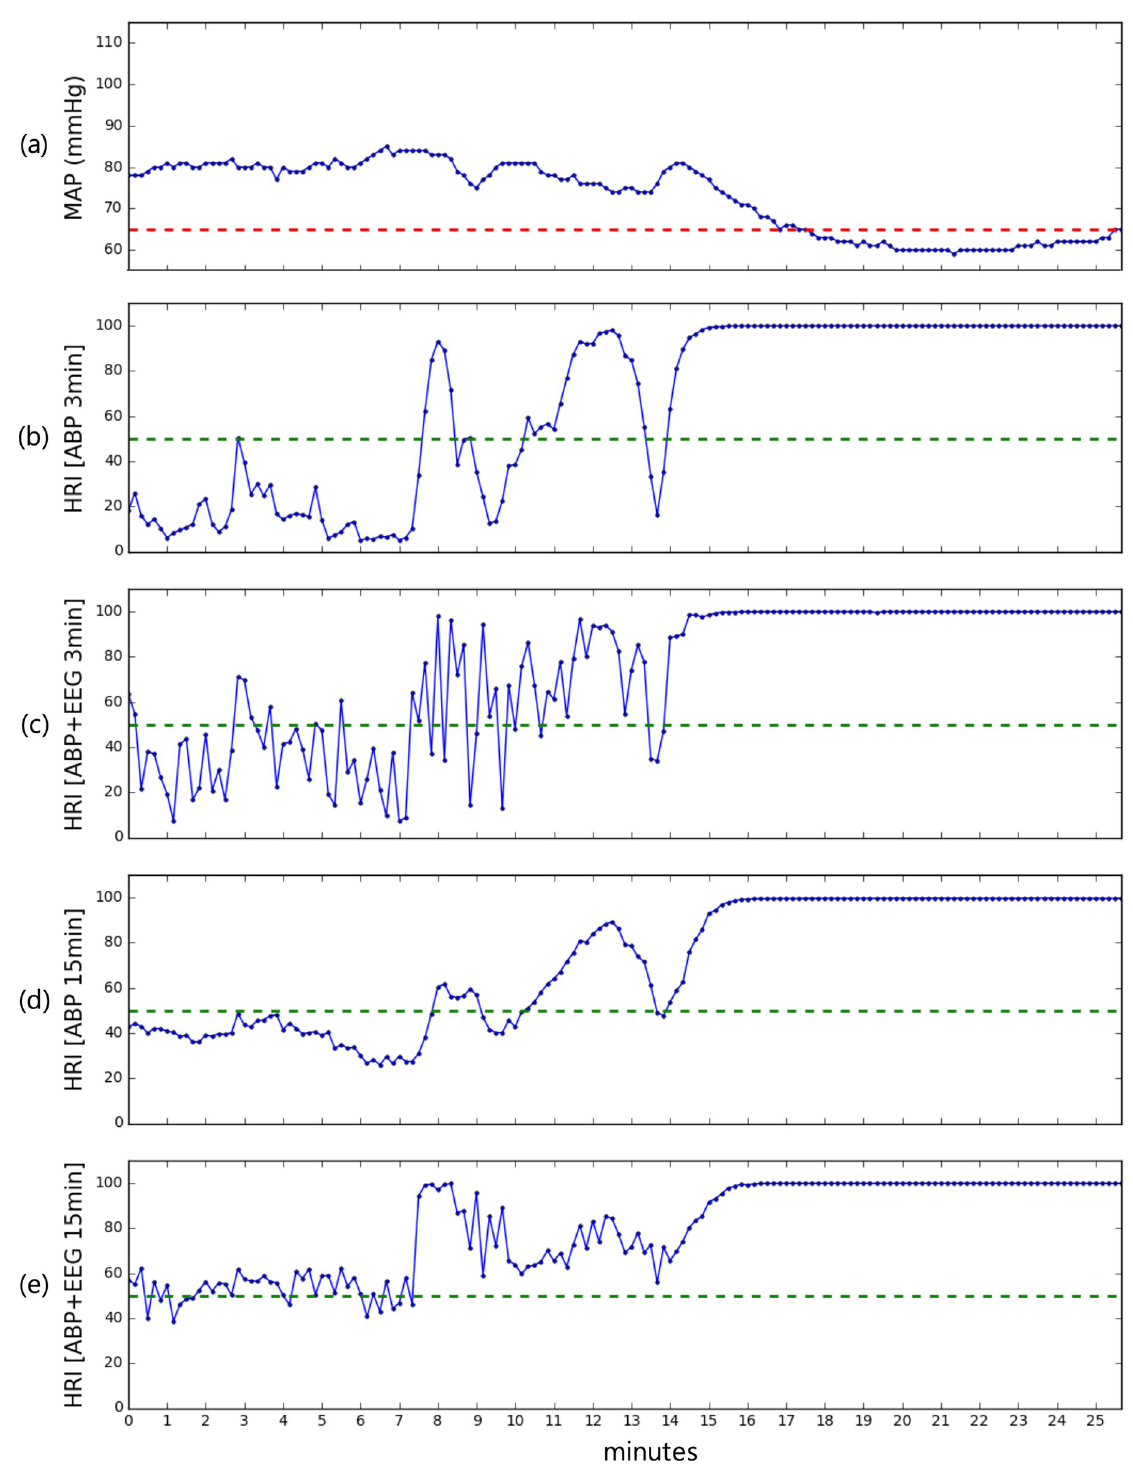
Fig 3. Illustrative patient record demonstrating the trajectory of algorithm outputs from different combinations of inputs (time and signals) and mean arterial pressure. (a) Trajectory of MAP. Red dash, 65 mmHg. (b) HRI from ABP waveform and (c) a combination of ABP and EEG for predicting event 3-min before, respectively. (d) HRI from ABP waveform, and e a combination of ABP and EEG waveforms for predicting event 15 min before. MAP, mean arterial pressure; HRI, hypotension risk index; ABP, arterial blood pressure; EEG,